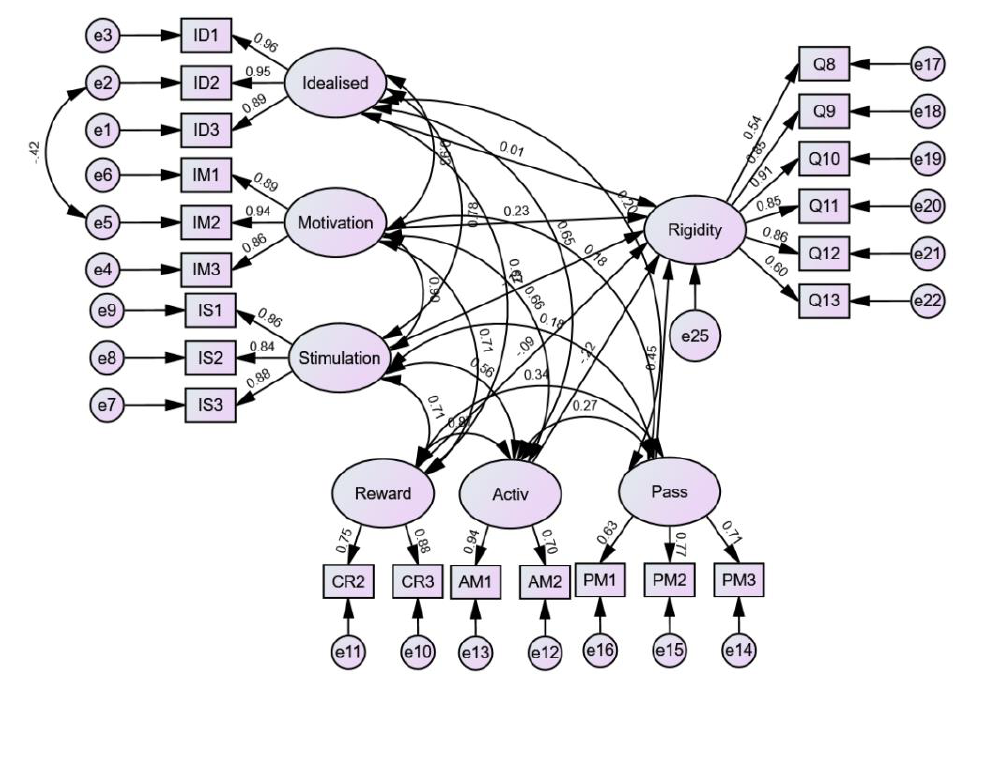
Figure 2: Model Indicating Relationship between